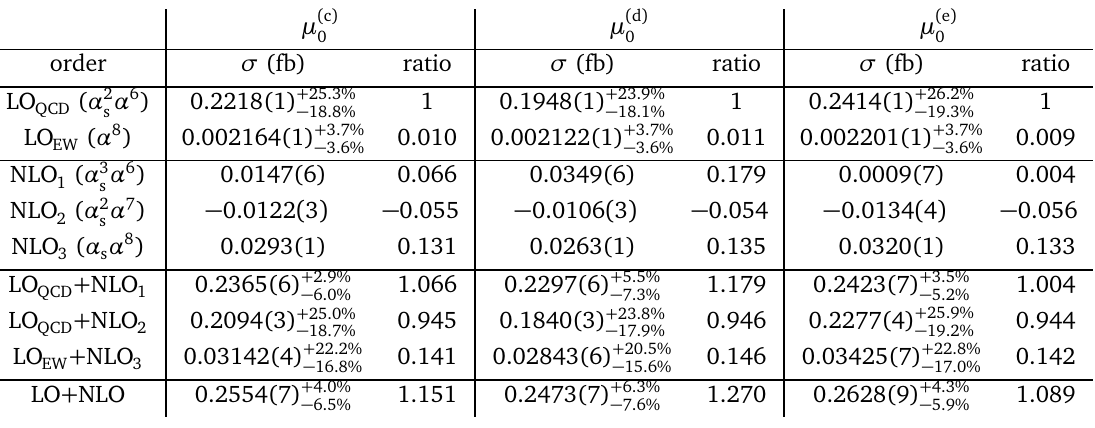
Table 1: Fiducial LO cross-sections and NLO corrections (in fb) for three different central-scale choices [ see Eq. (1) ] . Scale uncertainties from 7-point scale variations are shown in percentages. Ratios are relative to the LO QCD